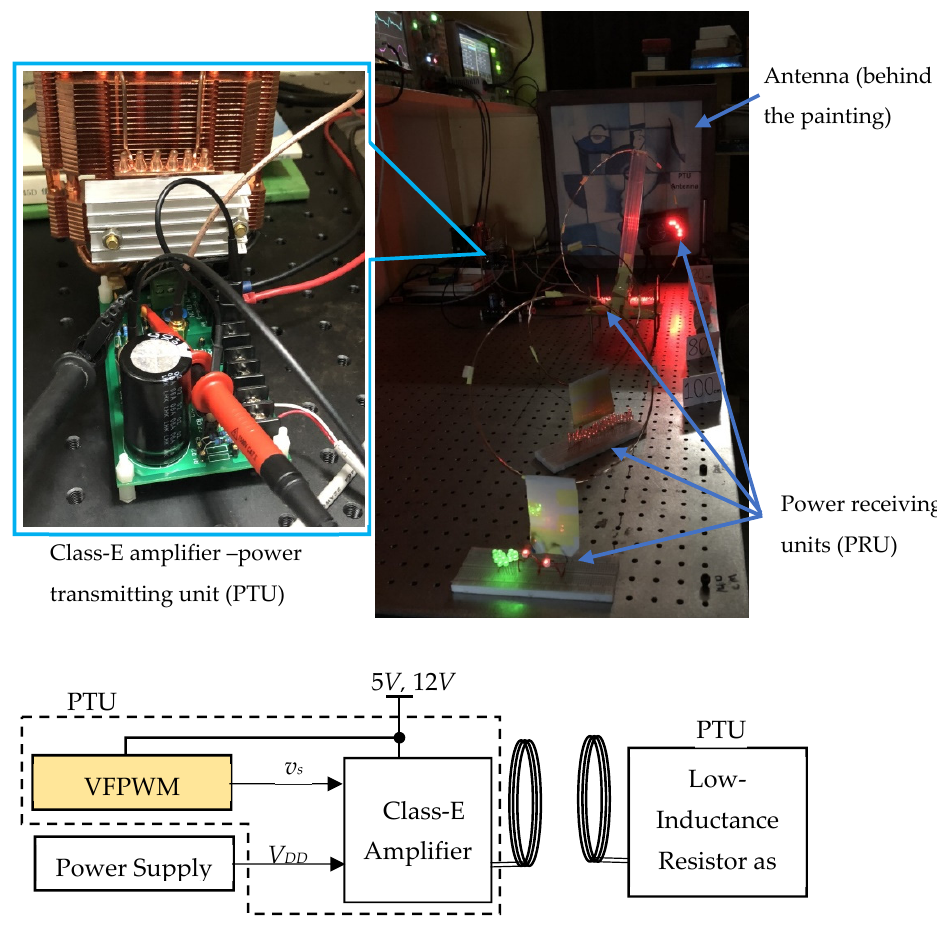
Figure 2. Experimental